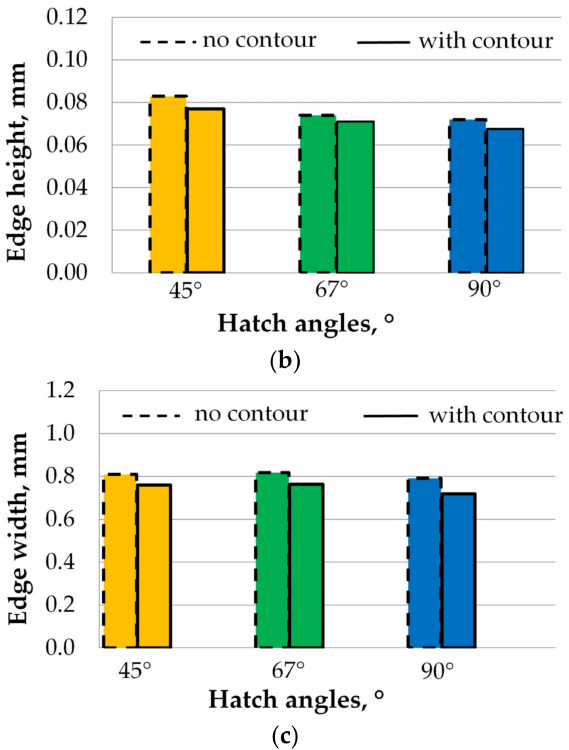
Figure 5. Corner and edge height and width of samples built with contour and without contour as a function of three hatch angle